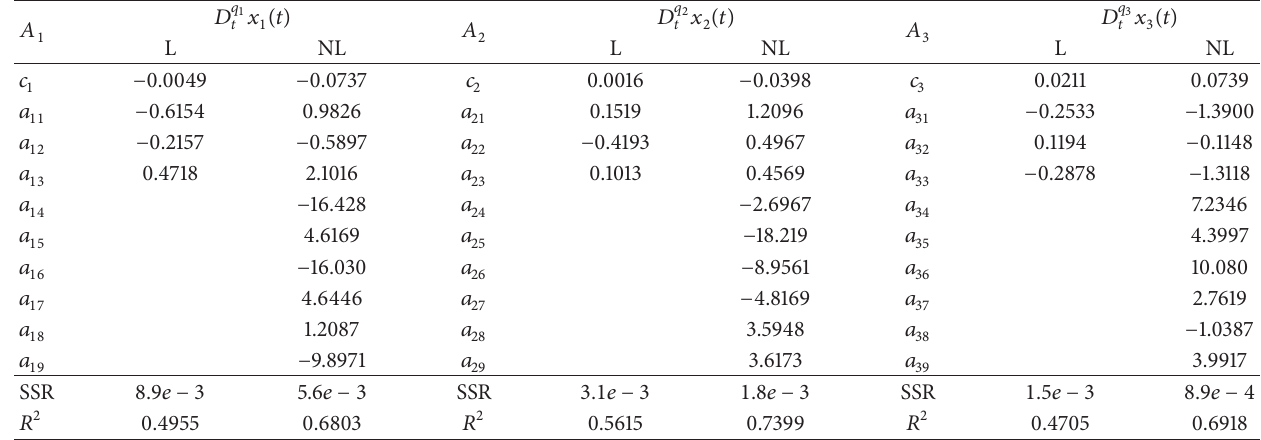
Table 2: The estimation results of parameters in model (12) with ℎ = 0.75 .